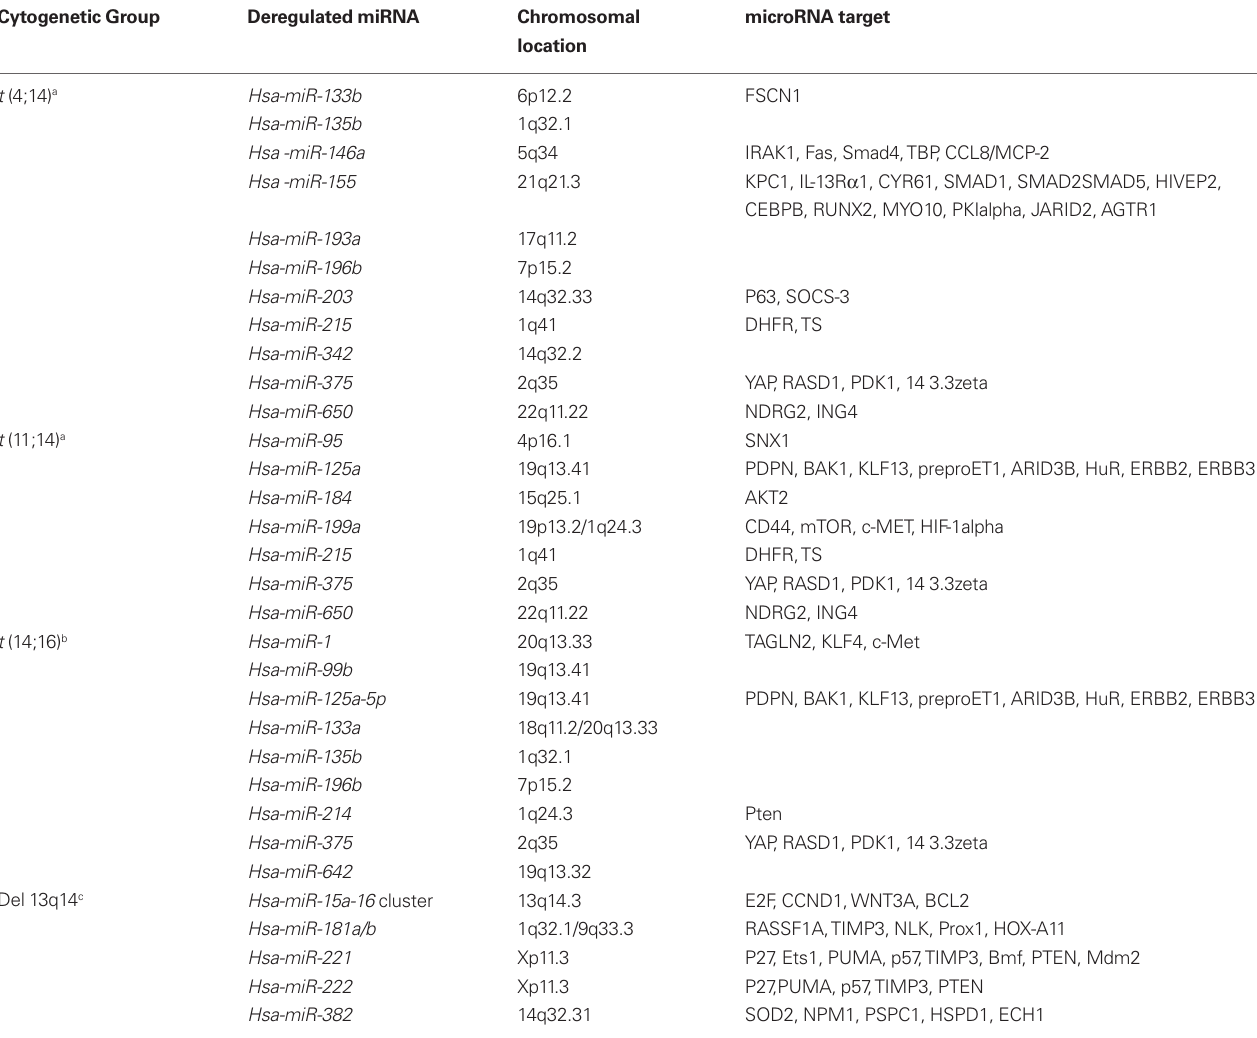
Table 1 | miRNA genes deregulated in specific cytogenetic aberrations in multiple myeloma. Cytogenetic